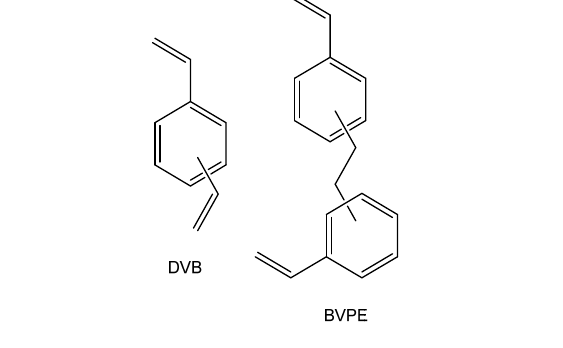
Figure 4. Chemical structures of crosslinking agents: divinylbenzene and bis (vinylphenyl) ethane.